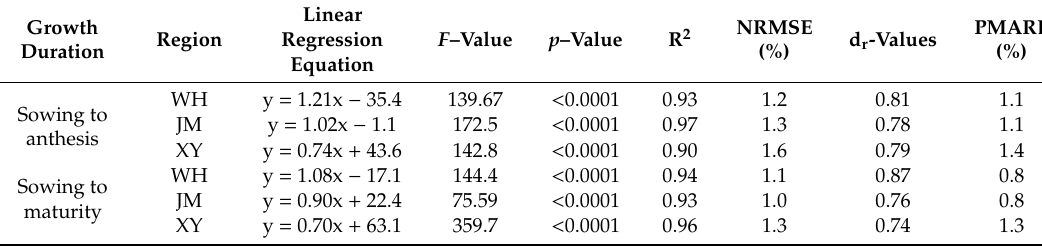
Table 5. The fitted equation for the linear relationships between the model-simulated and observed wheat growth duration and reliability measures: coe ffi cient of determination (R 2 ), normalized root mean square error (NRMSE), refined index of agreement (d r -values) and percent mean absolute relative error